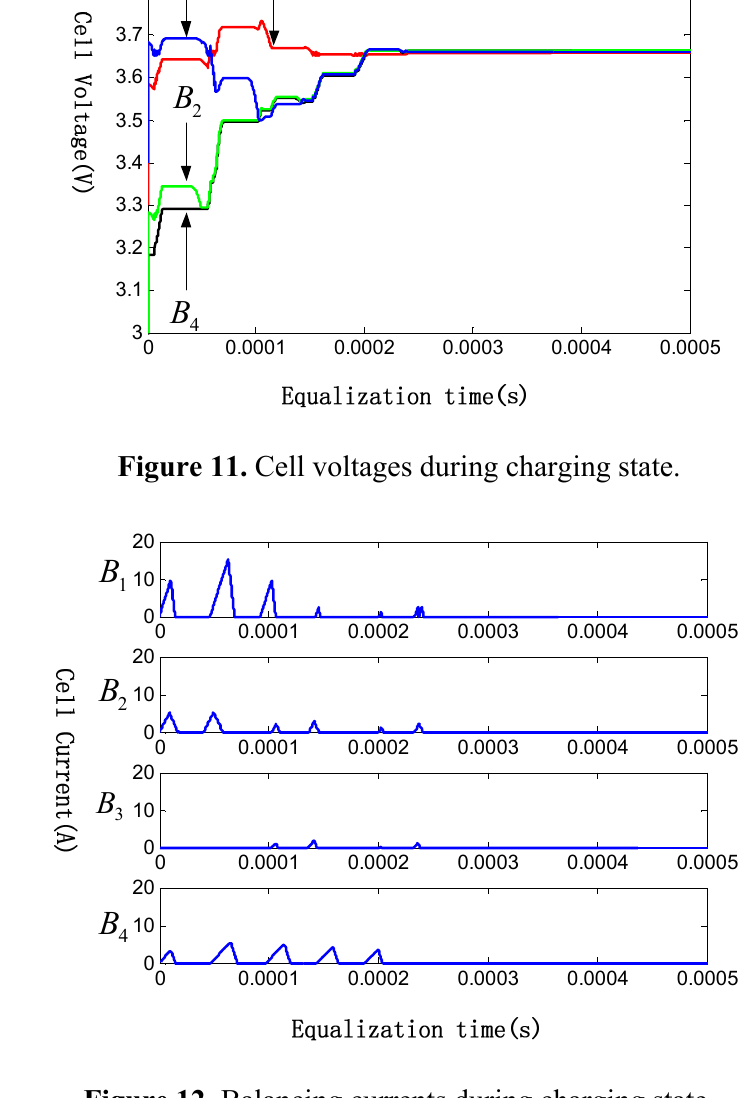
Figure 12. Balancing currents during charging